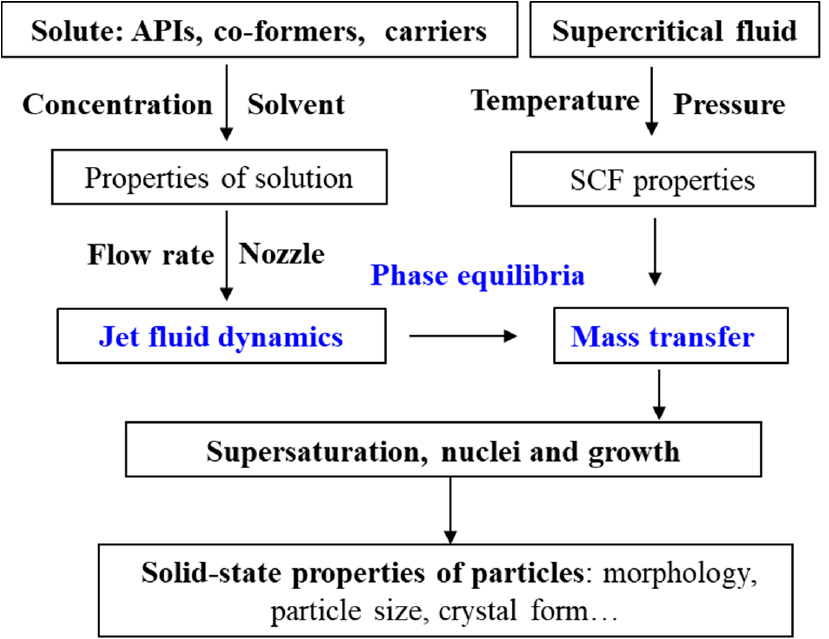
Figure 6. Influence mechanism of operating parameters on the solid-state properties of particles produced by the semi-continuous SAS process.